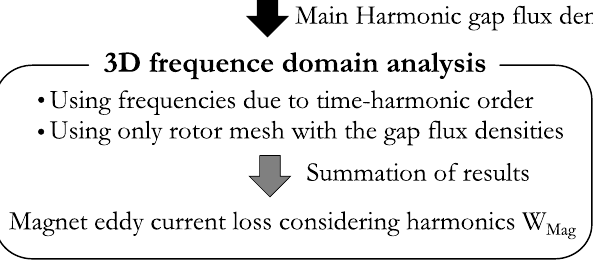
Figure 1. Outline of the proposed method